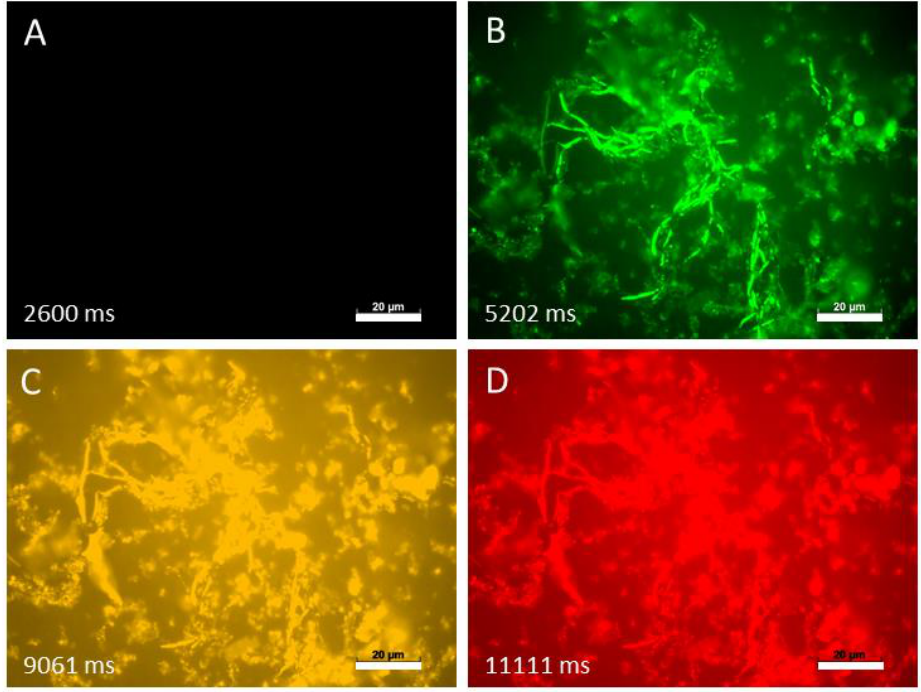
Figure 6. Autofluorescence of B. parvus . ( A ): DAPI channel; ( B ): FITC channel; ( C ): DsRed channel; ( D ): rhodamine channel. Picture exposure times are depicted in milliseconds (ms). Scale bar = 20 µm.